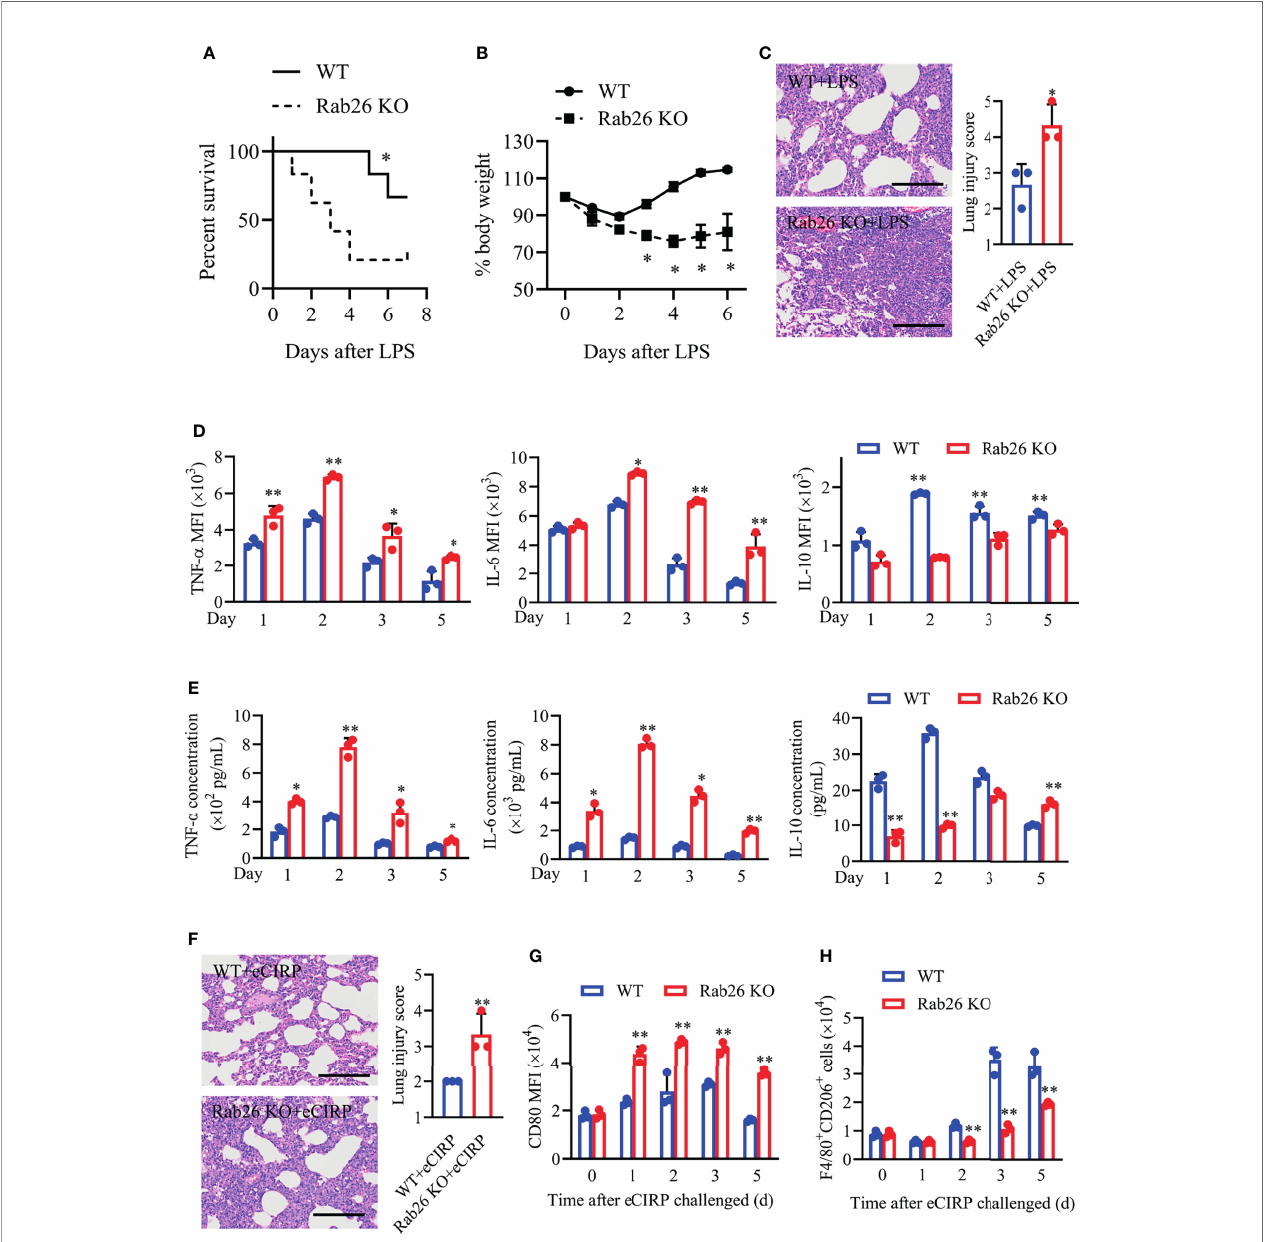
FIGURE 5 | Rab26 is critical for the eCIRP-mediated in fl ammatory response in lung injury. (A) Rab26 -/- and WT mice were challenged with 10 mg/kg LPS i.t., and survival was monitored (n = 6). (B) Rab26 -/- and WT mice were treated with 3 mg/kg LPS (i.t.). Change in body weight was monitored over 6 days (presented as % change from initial body weight) (n = 4 for each group). (C) Lung tissue samples from mice with LPS administration for 48 h were dissected and subjected to H&E staining. Lung injury scores were analyzed (n = 3). Scale bar: 150 µm. Macrophages (F4/80 + ) in BALF from WT and Rab26 -/- mice were collected at days 1, 2, 3, and 5 after eCIRP (1 mg/kg, i.t.) challenge. The MFIs of intracellular TNF- a , IL-6, and IL-10 in BALF macrophages (D) and the concentrations of TNF- a , IL-6, and IL- 10 in BALF (E) at indicated time were measured (n = 3). (F) Rab26 -/- and WT mice were treated with 1 mg/kg eCIRP (i.t.) at the indicated times. Lung tissue samples from mice with eCIRP administration for 48 h were dissected and subjected to H&E staining. Lung injury scores in each group were analyzed (n = 3). Scale bar: 150 µm. The MFIs of CD80 in BALF macrophages (G) and the number of F4/80 + CD206 + macrophages (H) were measured by FACS (n = 3). Data are representative of at least two independent experiments. Results were expressed as mean ± SD. * P < 0.05, ** P < 0.01 vs. the WT group at indicated time. Statistics: Log-rank test (A) or unpaired two-tailed Student ’ s t-test (B – G) . LPS, lipopolysaccharide; BALF, bronchoalveolar lavage fl uid; eCIRP, extracellular cold-inducible RNA-binding protein; WT, wild type; MFI, mean fl uorescence intensity; FACS, fl uorescence activated cell